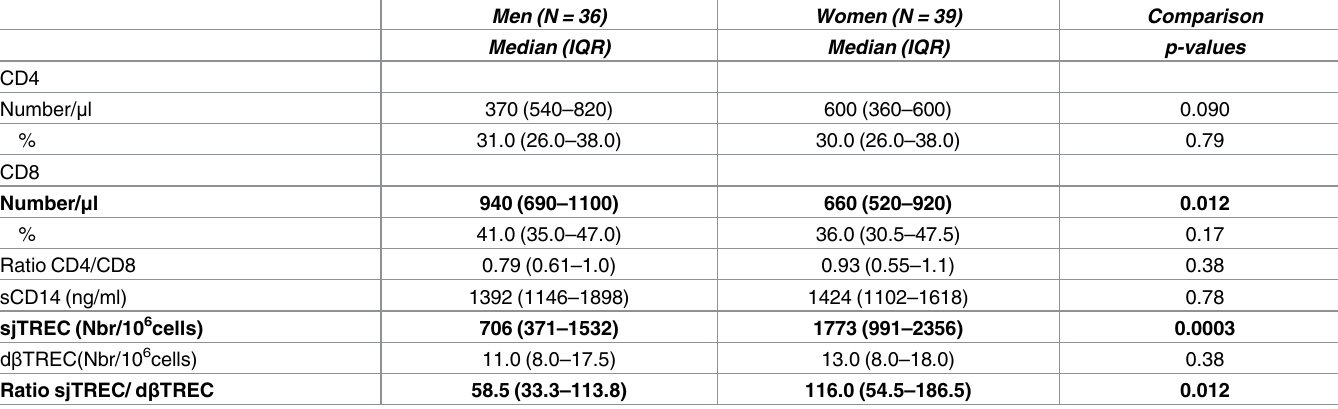
Table 1. Impact of the sex on observed blood markers of 75 HIV+